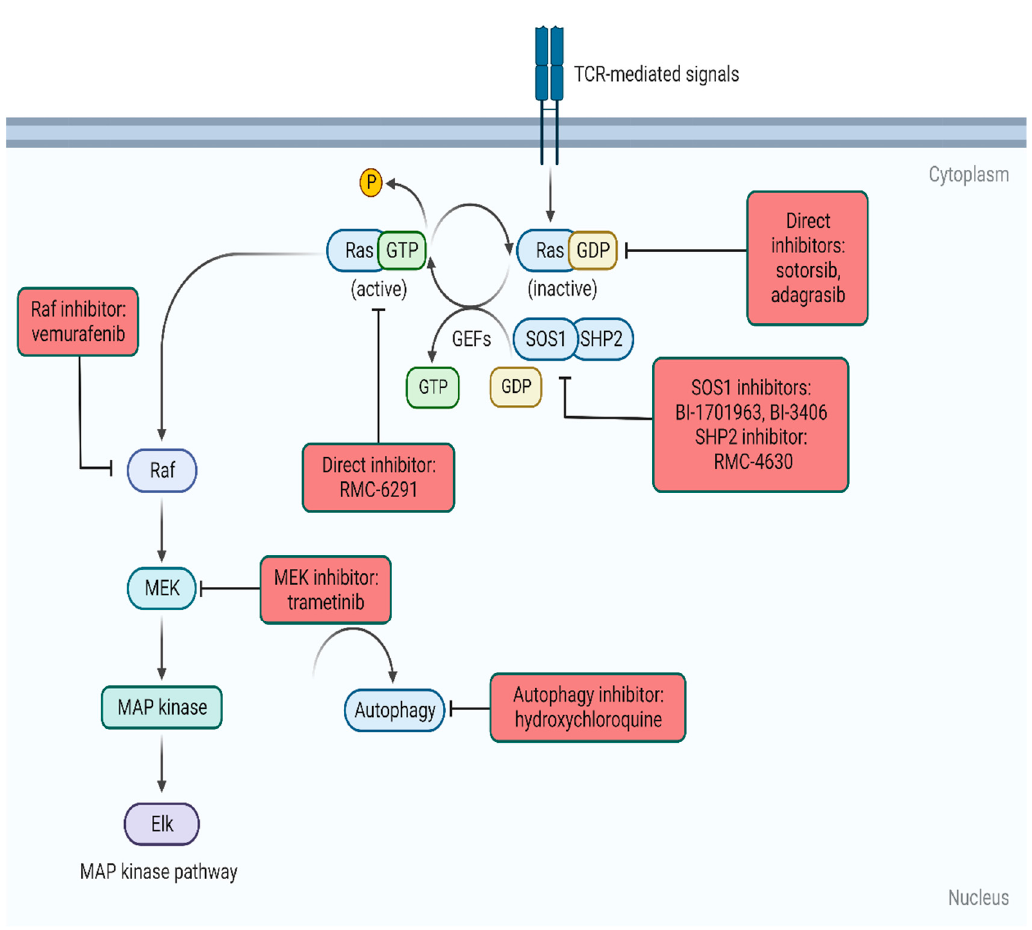
Figure 1. Intracellular targeting of RAS. Created with Biorender.com (accessed on 30 October